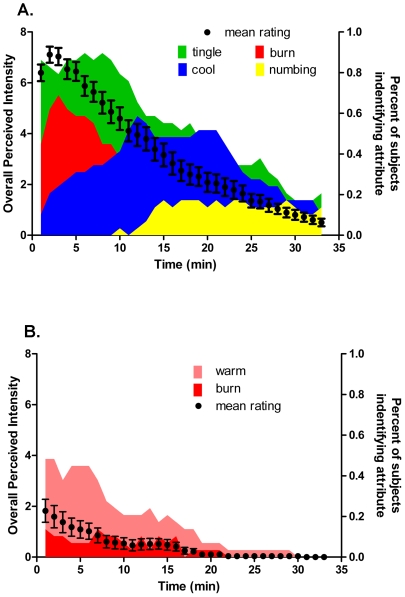
Temporal profile and attribute identification following lingual IBA (or vehicle) application.(A) Figure shows the mean overall intensity perceived over time (black dots) and the proportion of panelists selecting tingle (green), burning (red), cooling (blue) or numbing (yellow) at each time point. Note that initially, lingual IBA evoked a sensation that was characterized as both tingling and burning followed later by a sensation described primarily as tingling and cooling with some evidence of anesthesia. Error bars indicate SEM. (B) Application of vehicle (PG) elicited neither tingle nor cooling but did evoke an initial sensation characterized as warming. Format as in A.